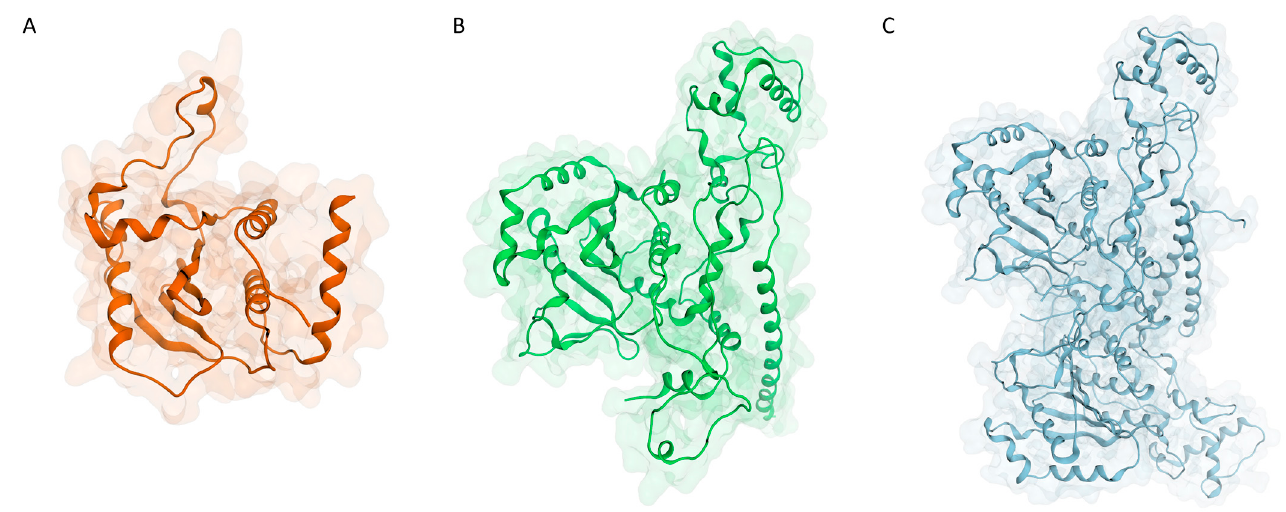
Figure 1. Structure of the three models generated for the monkeypox I7L protease: ( A ) monomeric model generated with Phyre2 using S. cerevisiae Ulp-1 protease (PDB ID: 1EUV) as a template; ( B ) monomeric model generated with AlphaFold2; ( C ) dimeric model generated with AlphaFold2.